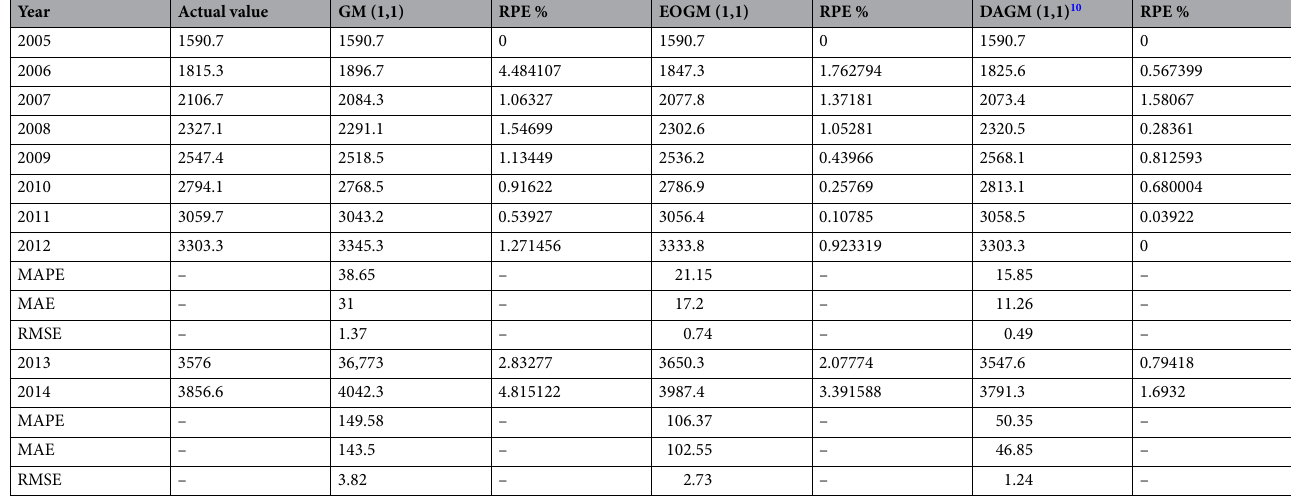
Table 2. Case 1: Forecasting results of different grey models 44 .